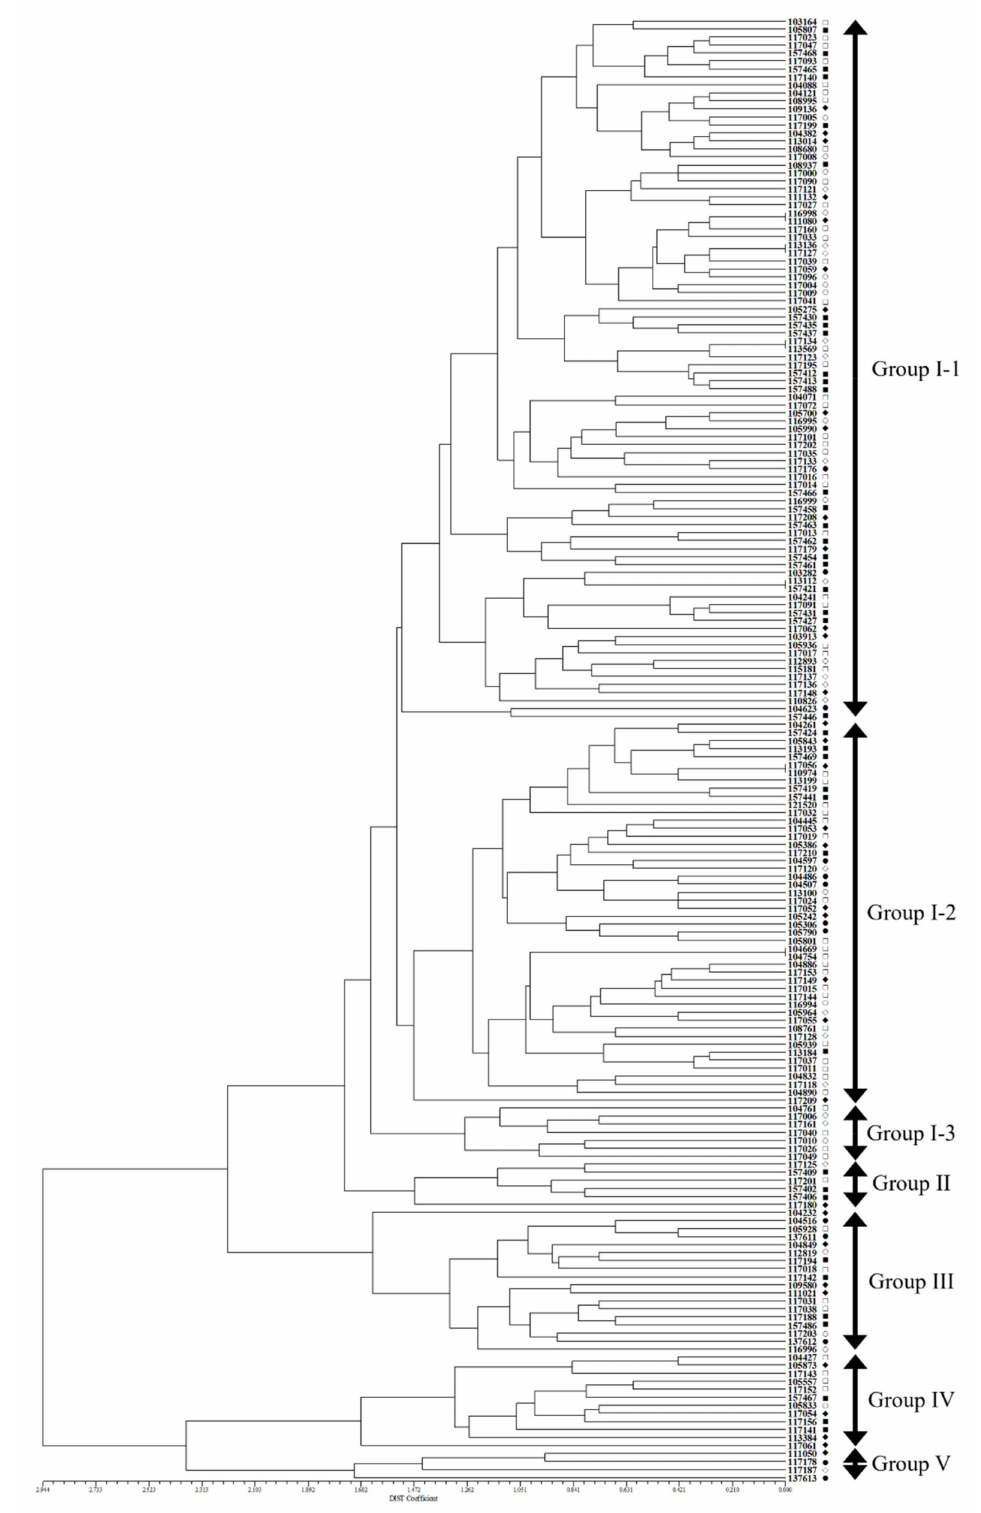
Figure 1. Dendrogram of the 183 accessions of native Perilla frutescens var. frutescens based on 11 morphological traits. The major clusters are marked on the right side of the dendrogram. The scale at the bottom is DIST coefficient of